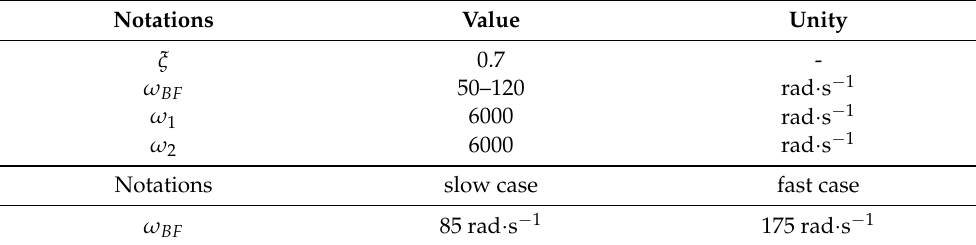
Table 1. Control